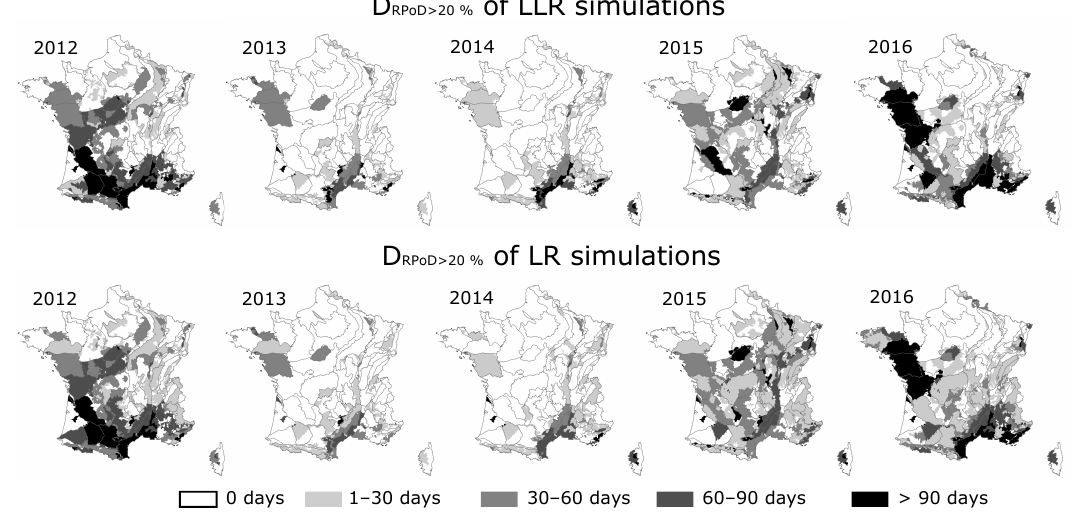
Figure 11. Maximum duration of consecutive days with RPoD higher than 20% simulated with the LLR and LR models.